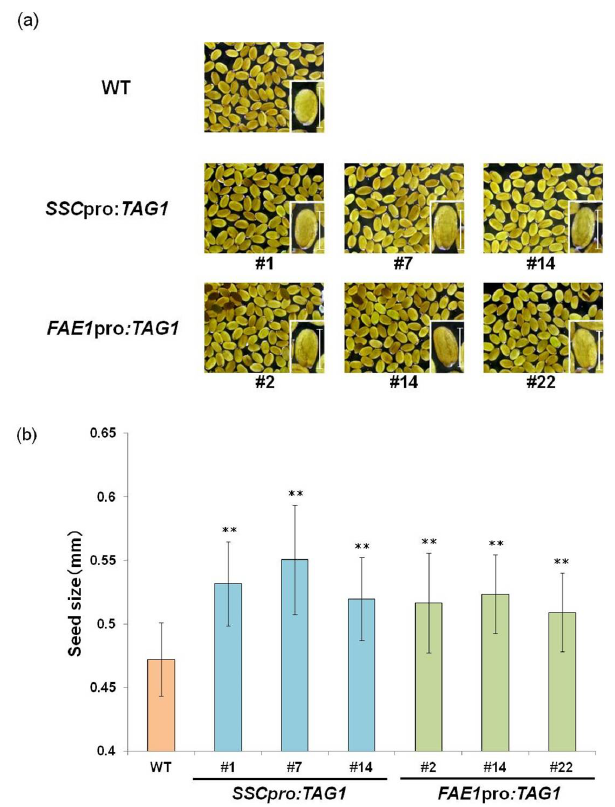
Figure 5. Seed size of transgenic plants. ( a ) Images and ( b ) the length of seeds that accumulated the three highest amounts of TAG among transgenic lines expressing TAG1 under control of the SSC promoter or FAE1 promoter. Scale bars = 0.5 mm. Values are means ± standard deviation of measurements of 50 seeds. Asterisks indicate a significant difference between the wild-type (WT) and transgenic lines at p < 0.01 (**).